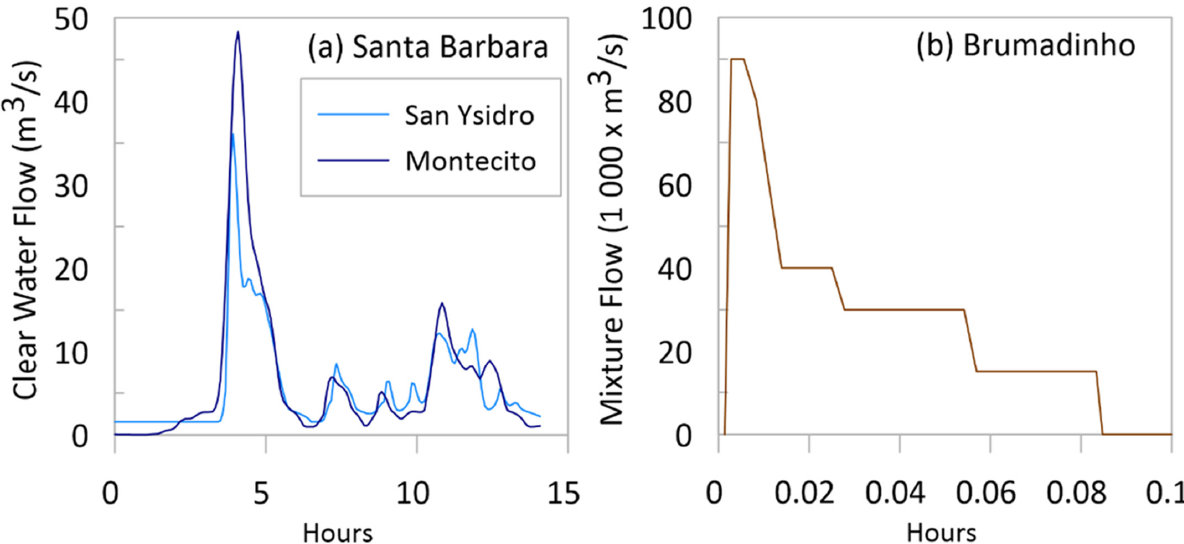
Figure 1. Hydrographs used in the models including ( a ) clear water hydrographs for the Santa Barbara models from USACE (2022) [17] and ( b ) Lumbroso et al.’s (2021) [20] stepped, multi-phase fluid hydrograph for the Brumadinho failure.